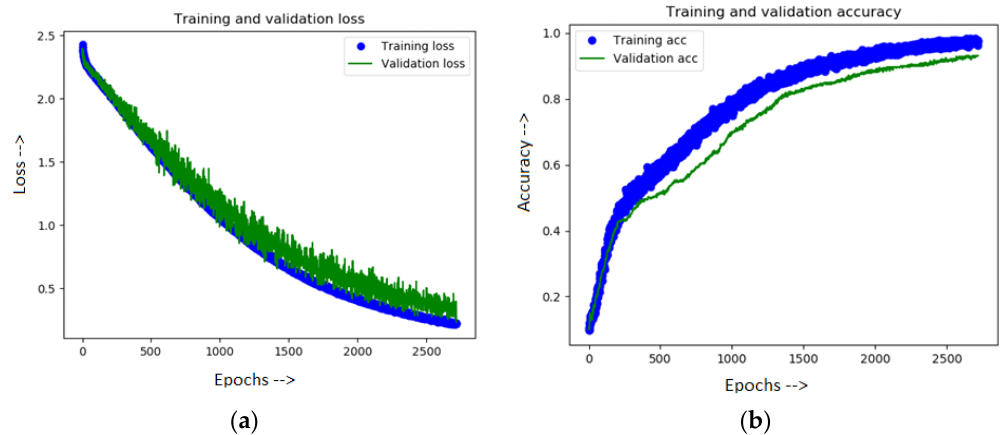
Figure 11. Training and validation history plots when the total class is 10: ( a ) Loss vs. epochs; ( b ) Accuracy